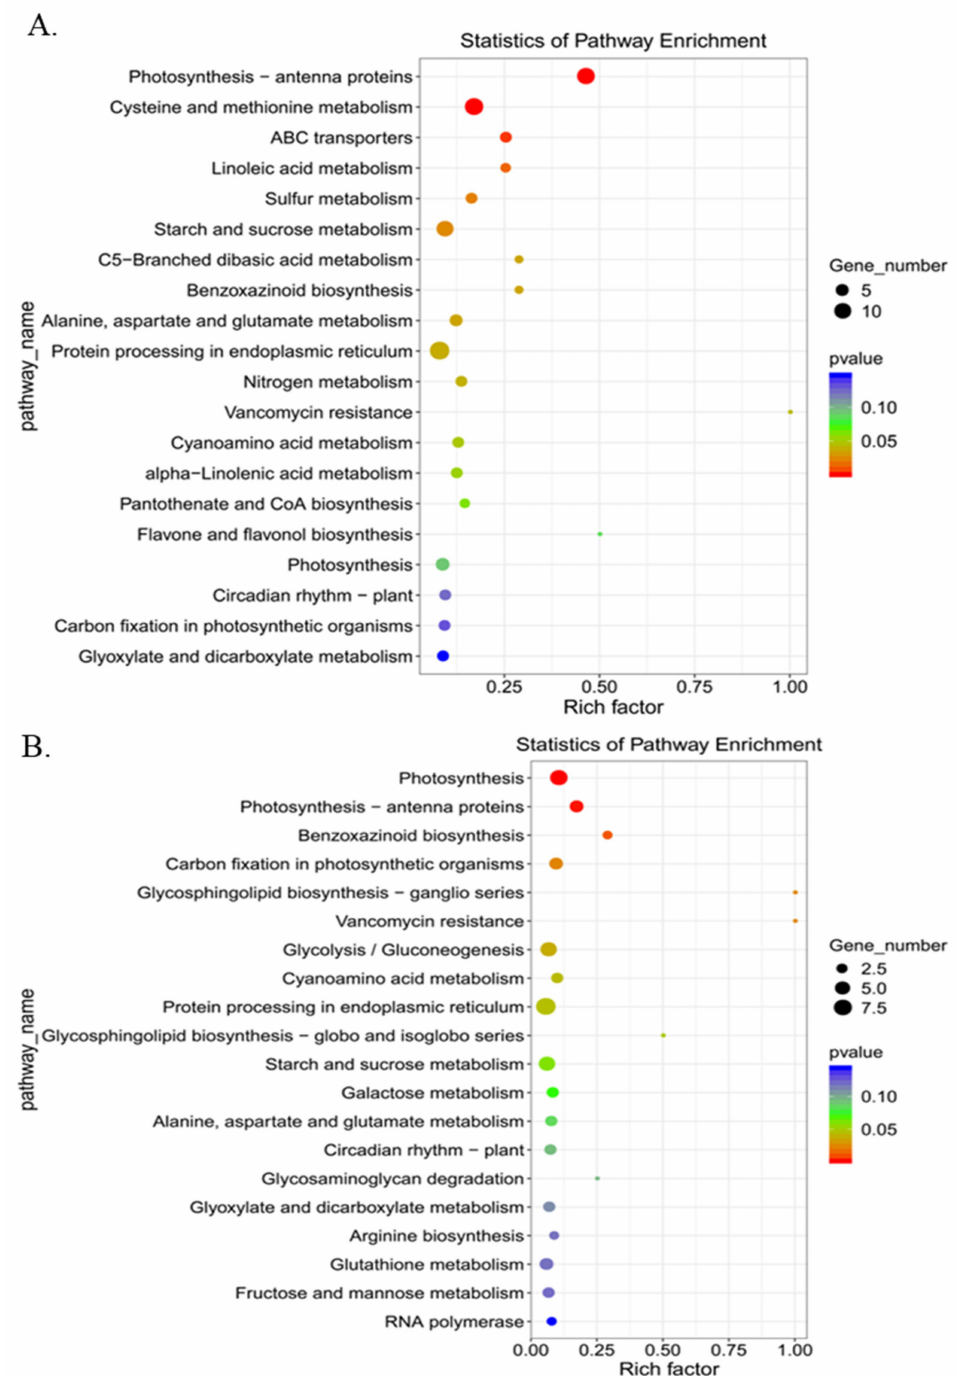
Figure 3. Kyoto Encyclopedia of Genes and Genomes (KEGG) enrichment analysis for the conserved DEGs within ZD309 and its parental lines in H3HS ( A ) and H6HS ( B ) treatments. The overlapped DEGs among ZD309 and its parental lines in both D3HS and D6HS treatments were centered for further analysis (Figure 4A). A total of 299 DEGs (198 up- and 93 down-regulated) were suggested to be important for heat tolerance. These